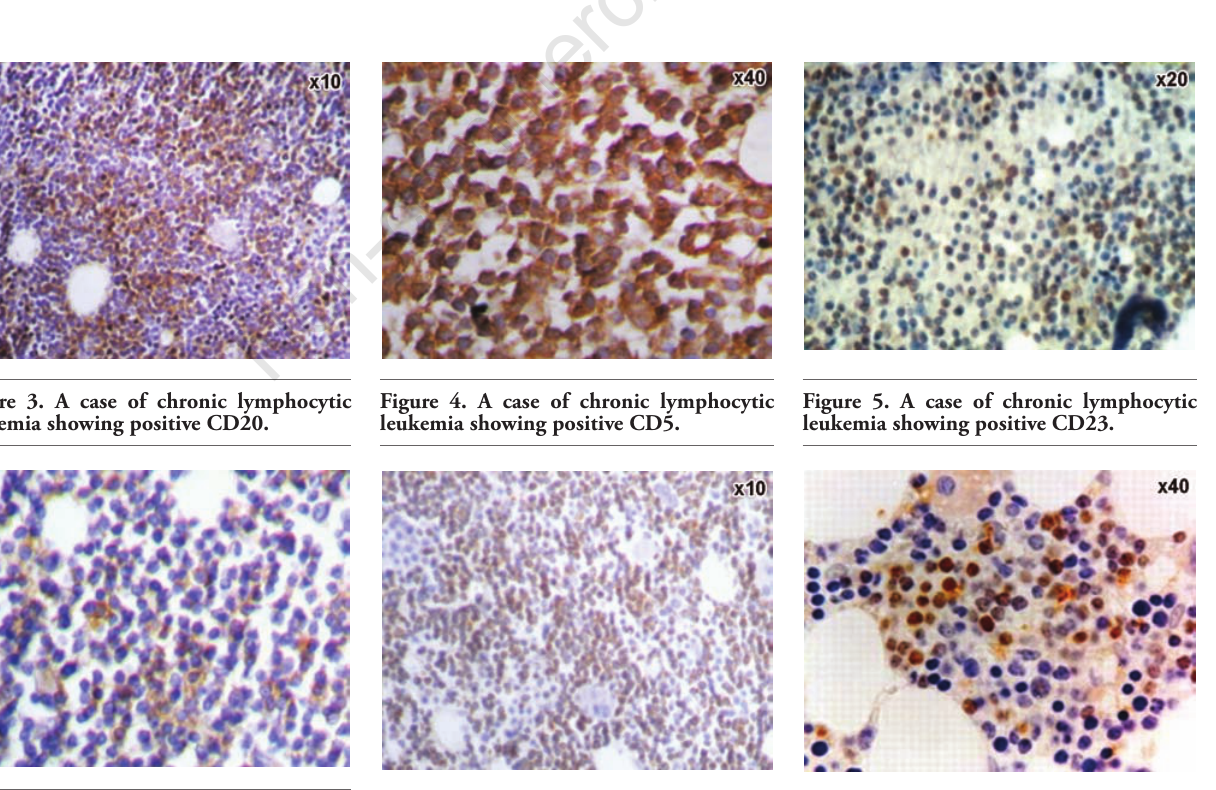
Figure 6. Light chain restriction: kappa restriction in a case of chronic lymphocytic leukemia.